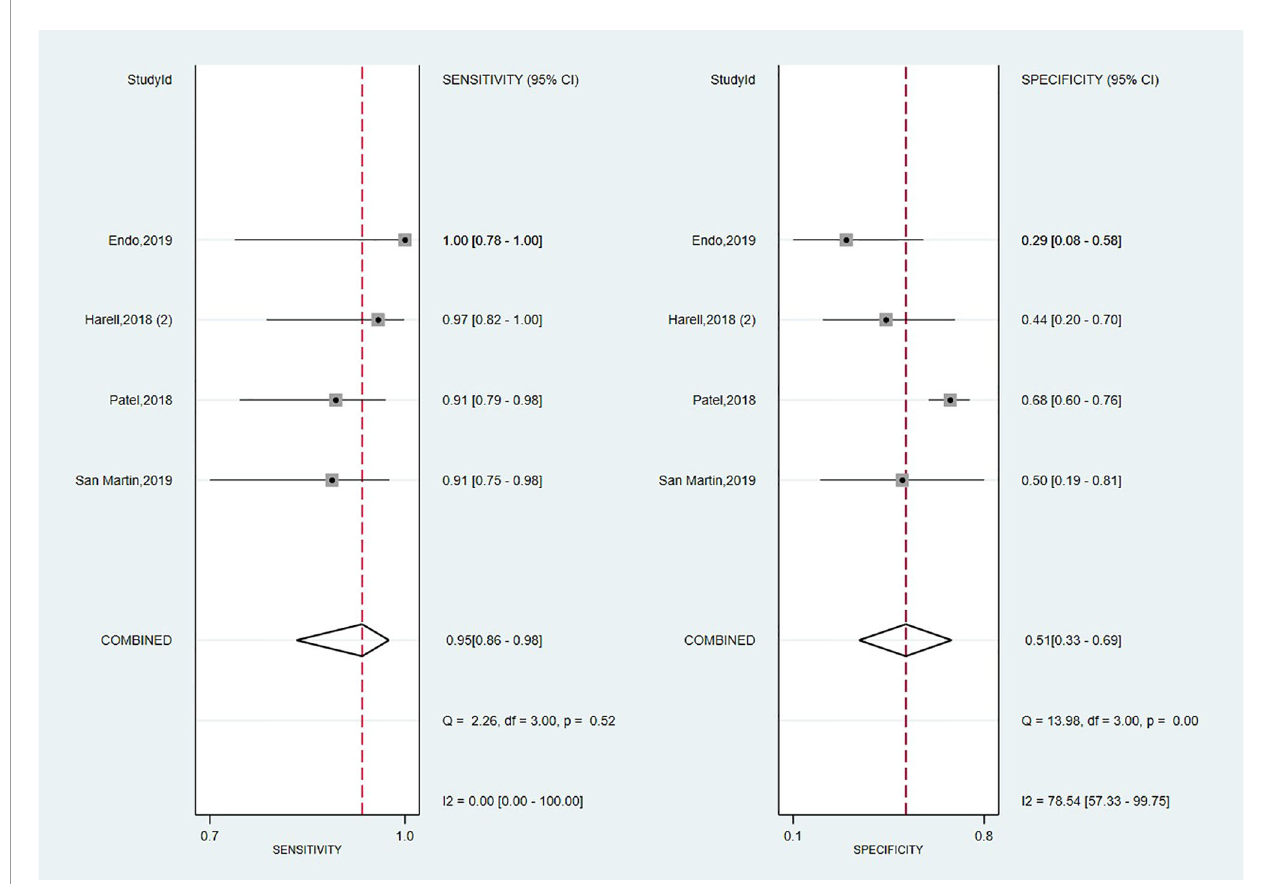
FIGURE 4 | Forest plot of sensitivity and speci fi city for A fi rma GSC